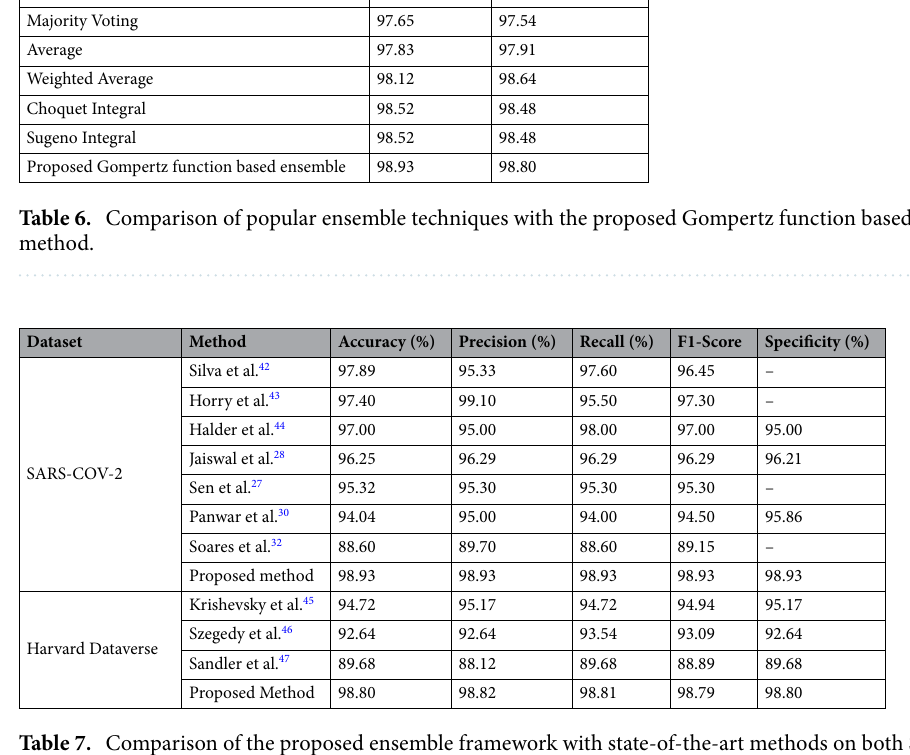
Table 7. Comparison of the proposed ensemble framework with state-of-the-art methods on both SARS- COV-2 and Harvard Dataverse datasets.